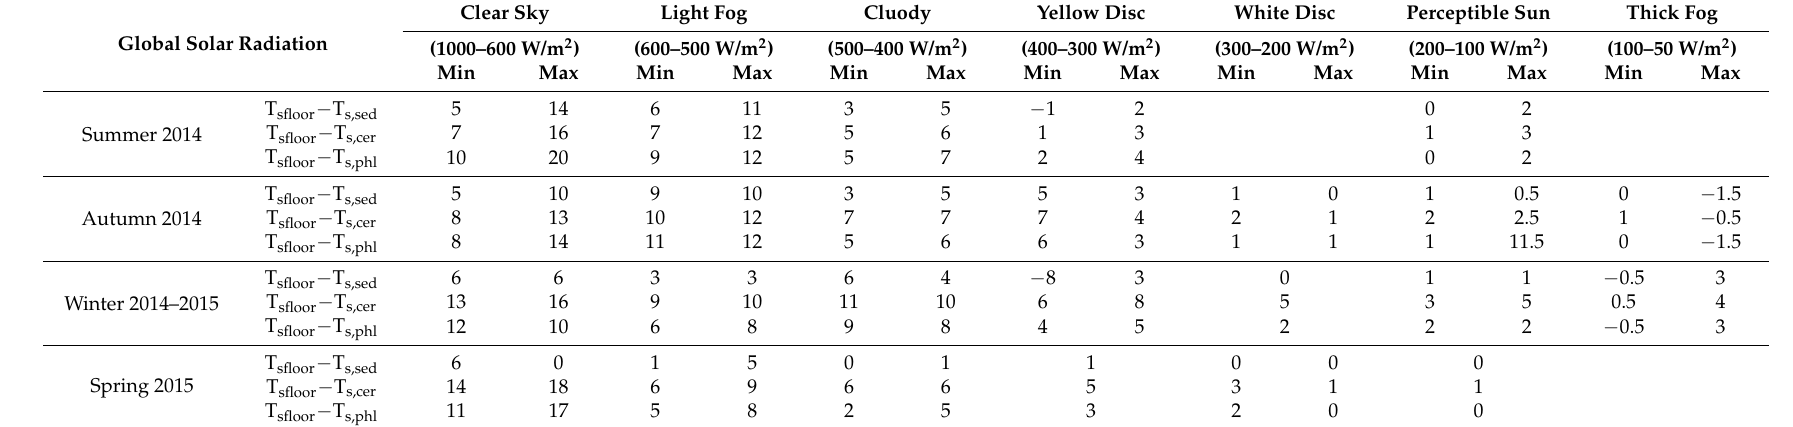
Table 8. Surface temperatures thermal gradients (T s ) as a function of the solar radiation level